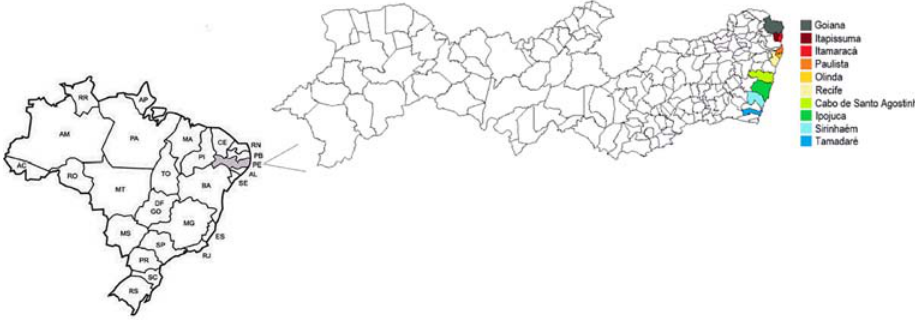
Figure 1. Study area. The map shows all states in Brazil and the gray-shaded area is the state of Pernambuco, where the study was carried out. Colored areas indicate the counties visited for shell fi sh collection.